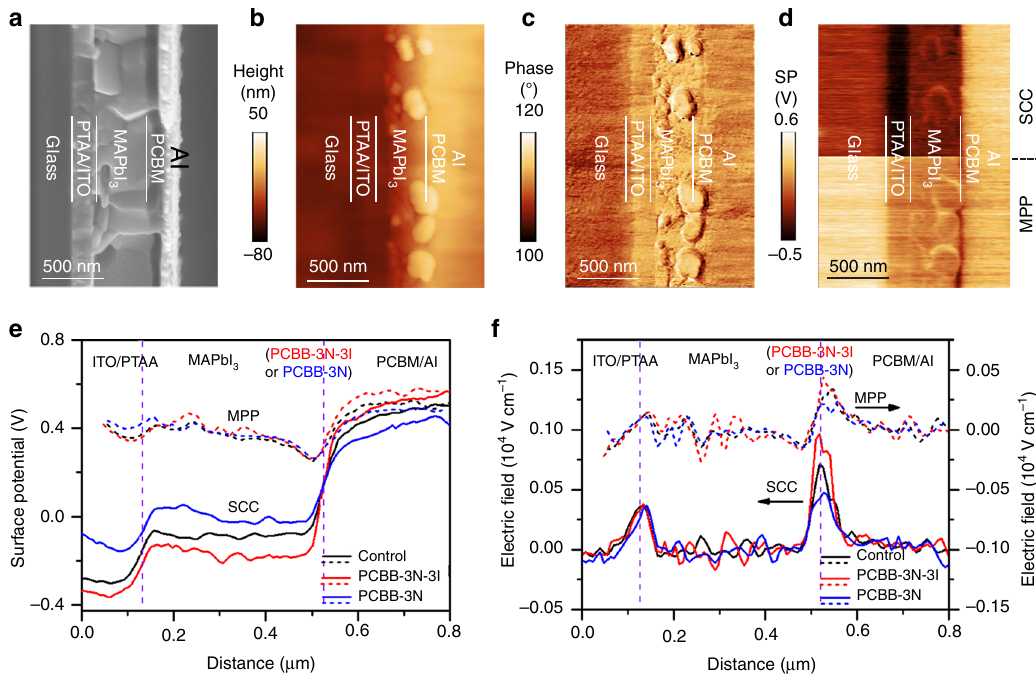
Fig. 3 Visualization of interfacial energy depth pro fi les in SCC and MPP. a – d Control device cross-section: a SEM image; b AFM topography image; c AFM phase image; d SKPM-measured SP image in SCC (top half) and MPP (bottom half). e SP depth pro fi les and f corresponding electric fi eld distribution of the control device (black), PCBB-3N-3I device (red), and PCBB-3N device (blue) in SCC (solid line) and MPP (dashed line)